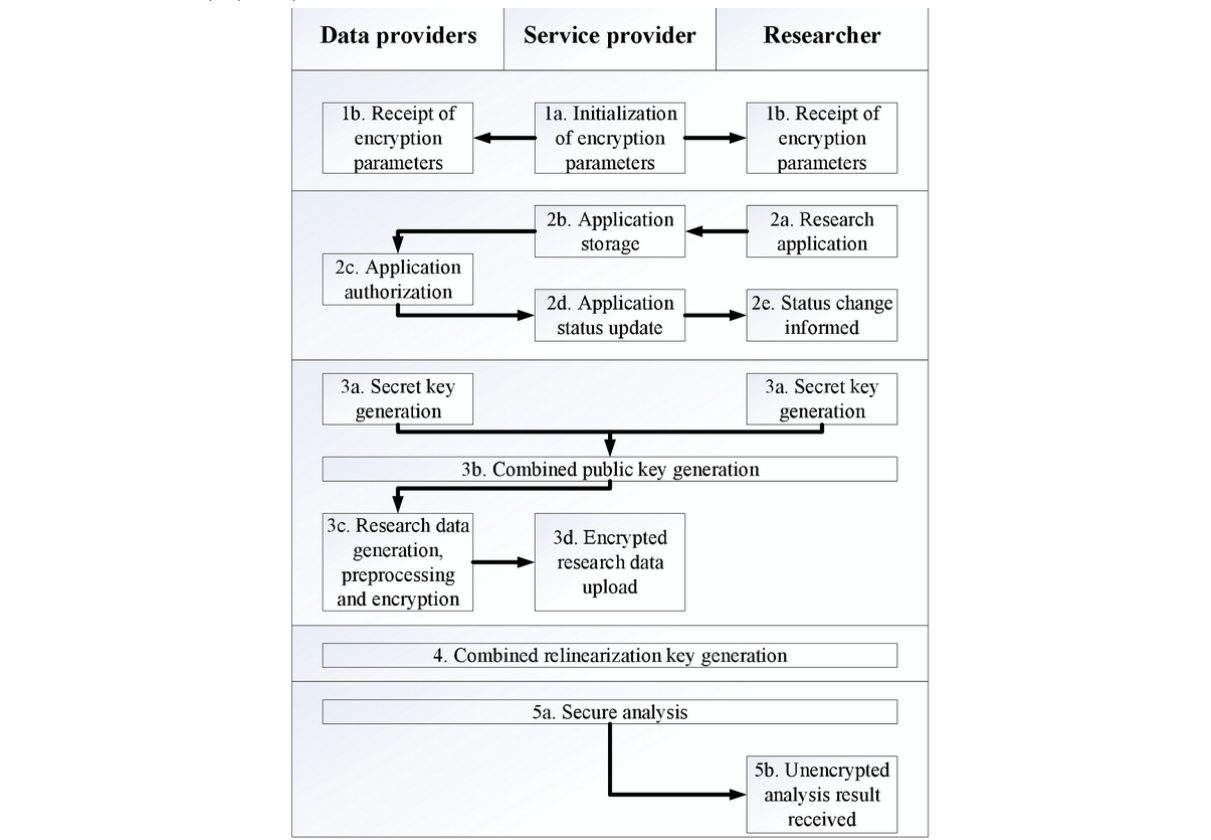
Figure 2. Workflow of the proposed